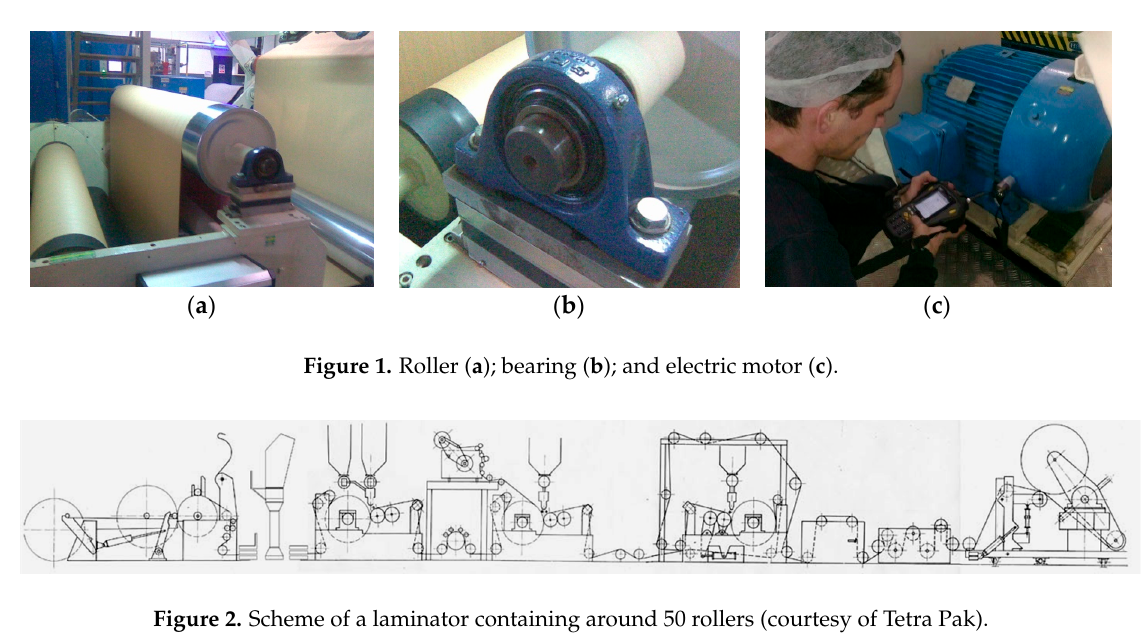
Figure 3. Predictive maintenance Potential to Functional Failure (P-F) curve.